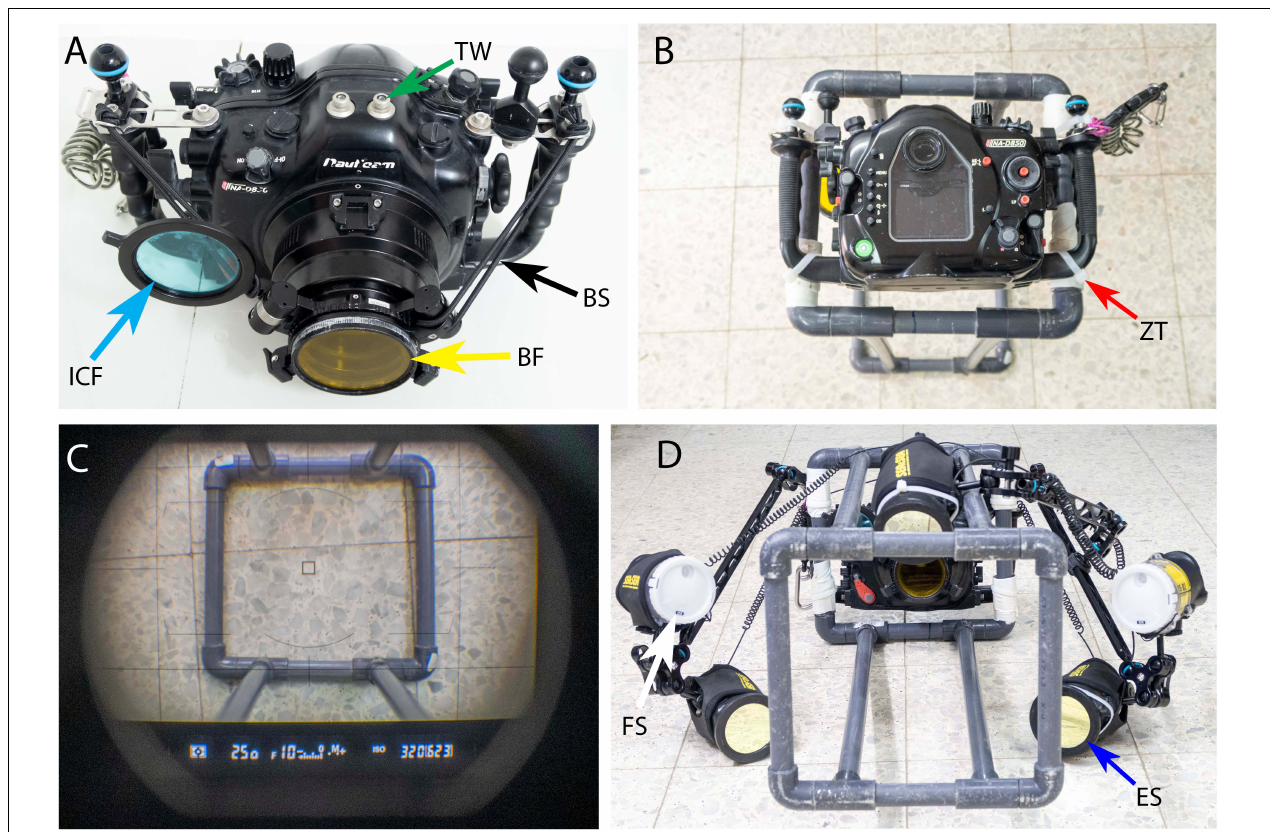
FIGURE 2 | (A) The Nauticam NAD850 camera housing with Nauticam double filter holder for a Barrier Filter (BF-yellow arrow) and Infrared Cut Filter (ICF-blue arrow). See the Bungee Straps (BS-black arrow) added to the setup that helps to retract the filter from the port in one finger touch and the Trigger Window (TW-green arrow) on the upper side of the housing. (B) The housing is mounted on the quadrat frame with Zip-Ties (ZT-red arrow). (C) A look via the camera viewfinder to verify if the camera is centered with the quadrat and the shooting parameters are correct. (D) The speed-FluorIS is mounted and ready to use with five strobes, 3 Excitation Strobes (ES-blue arrow) and 2 Full Spectrum (FS-white arrow) strobes.